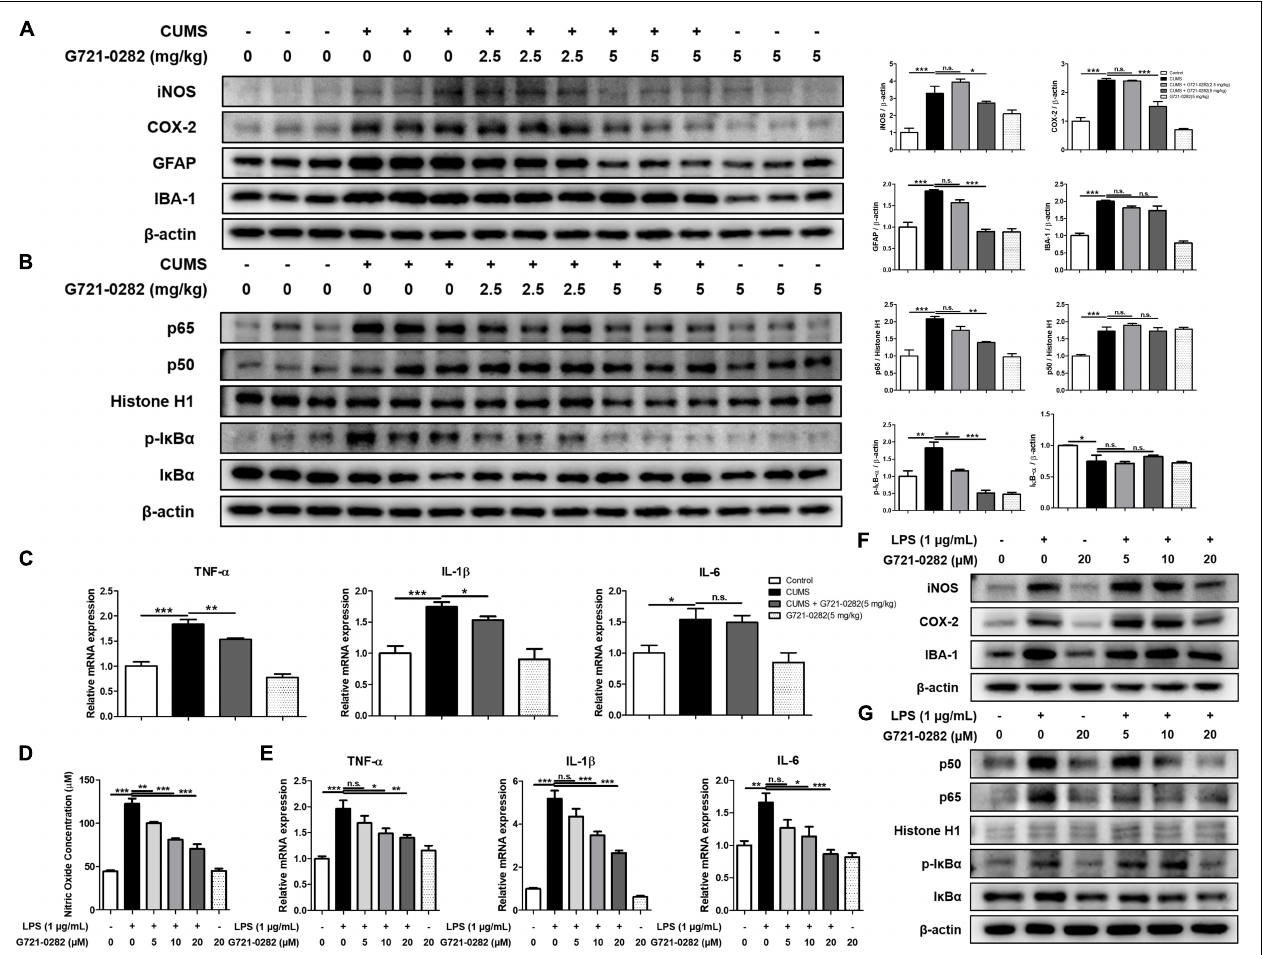
FIGURE 3 | Inhibitory effect of G721-0282 on CUMS and LPS-induced neuroinflammation. The expression of iNOS, COX-2, GFAP and IBA-1 were detected by Western blot in the mice brain (A) . The translocation level of p65 and p50 (Nuclear) and the phosphorylation level of I κ B were detected by Western blot in mice brain (B) . The loading control, β -actin, was reused in (A,B) and Figure 5D , because (A,B) and Figure 5D were obtained from the same amount of the same samples. The mRNA expression level of pro-inflammatory cytokines (TNF- α , IL-1 β , and IL-6) in the mice brain hippocampus site were assessed by qRT-PCR (C) . The effect of G721-0282 on Nitric Oxide production in BV-2 cells were measured by Nitric Oxide assay (D) . The mRNA expression level of pro-inflammatory cytokines (TNF- α , IL-1 β , and IL-6) in BV-2 cells treated with G721-0282 were assessed by qRT-PCR (E) . The expression of iNOS, COX-2, and IBA-1 were detected by Western blot in BV-2 cells treated with G721-0282 (F) . Phosphorylation of I κ B, and p50 and p65 (Nuclear) translocation were detected by Western blot in BV-2 cells treated with G721-0282 (G) . ∗ , Significantly different between two groups ( p < 0.05). ∗∗ , Significantly different between two groups ( p < 0.01). ∗∗∗ , Significantly different between two groups ( p <